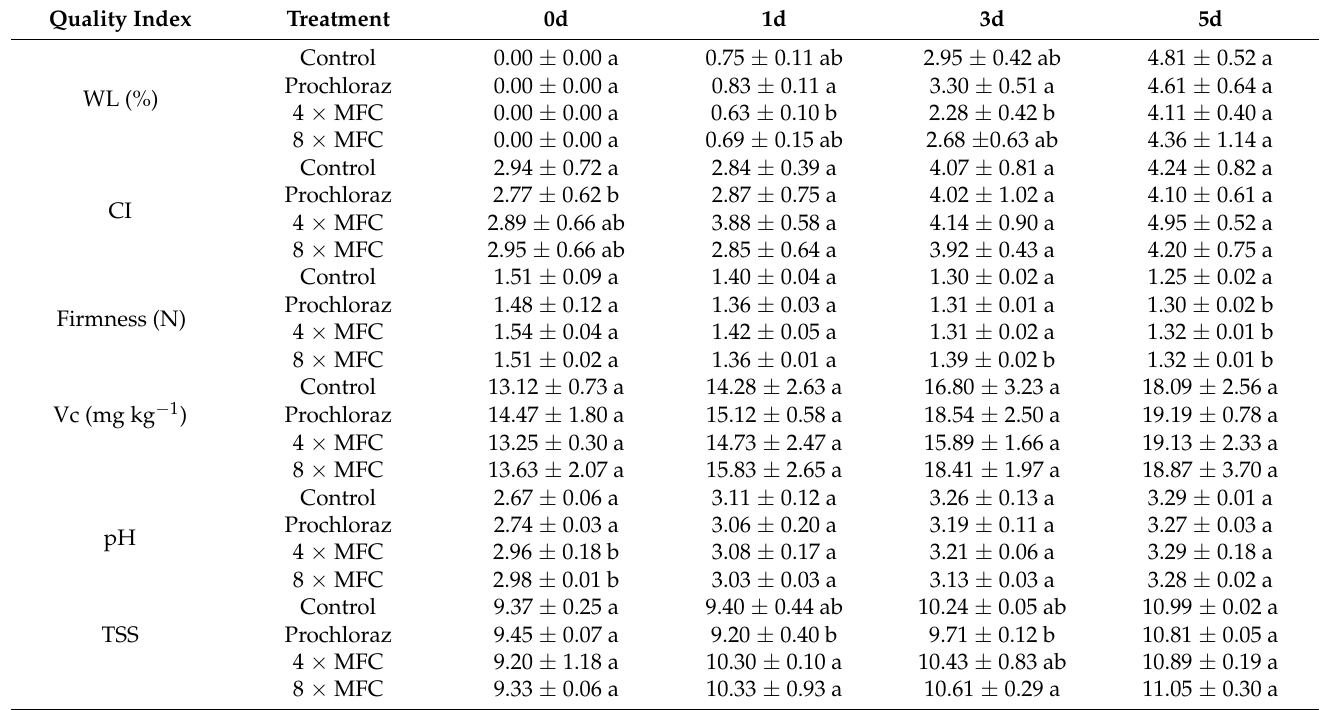
Table 1. Evaluation of the γ -CDCL (control, 4 × MFC and 8 × MFC) and Prochloraz treatments on post-harvest qualities of citrus fruit inoculated with P. digitatum